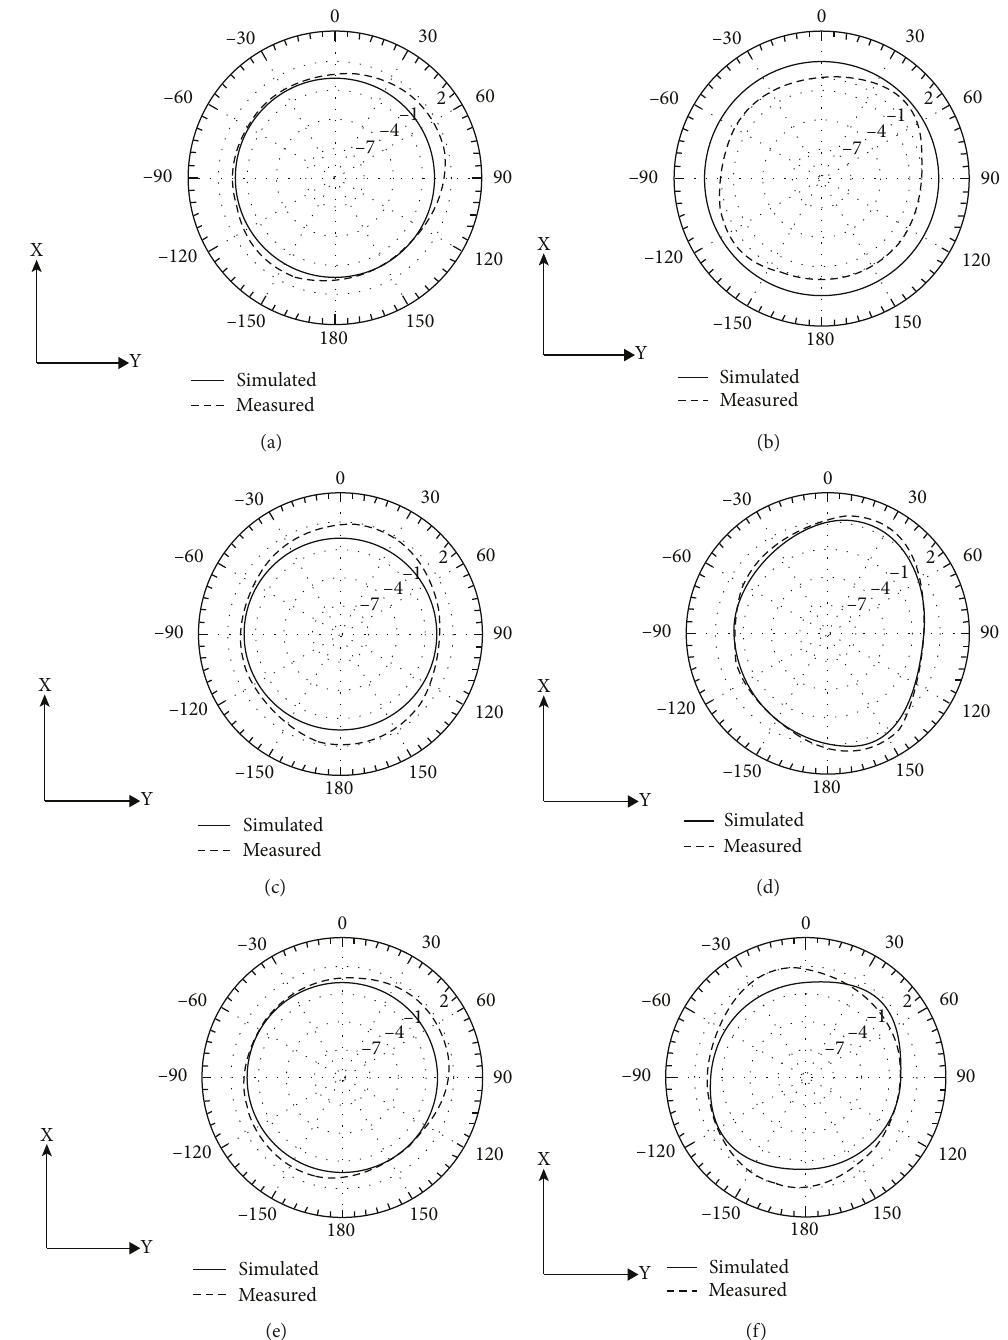
Figure 8: Directivity radiation patterns using linear scaling (a) XY plane at 0.75 GHz, (b) XY plane at 1.9 GHz, (c) XZ plane at 0.75GHz, (d) XZ plane at 1.9GHz, (e) YZ plane at 0.75GHz, and (f) YZ plane at 1.9